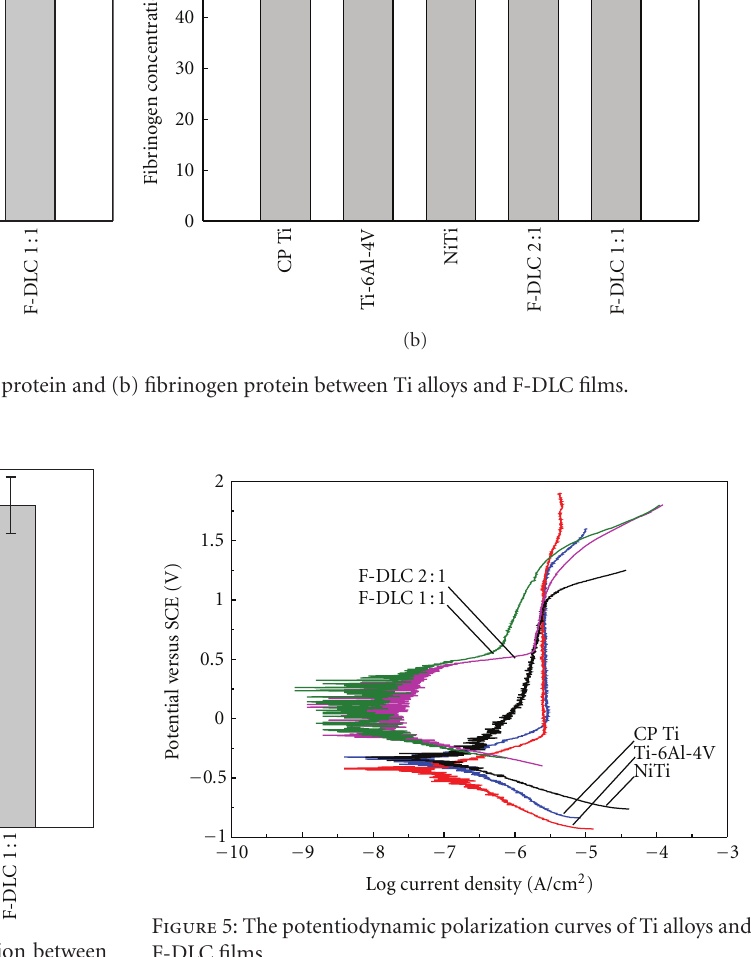
Figure 4: The ratio of albumin to fibrinogen adsorption between Ti alloys and F-DLC films.